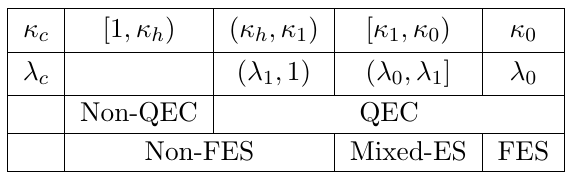
Table 3 . (cid:21) c and (cid:20) c can be used to classify the property of QEC and ES in tensor